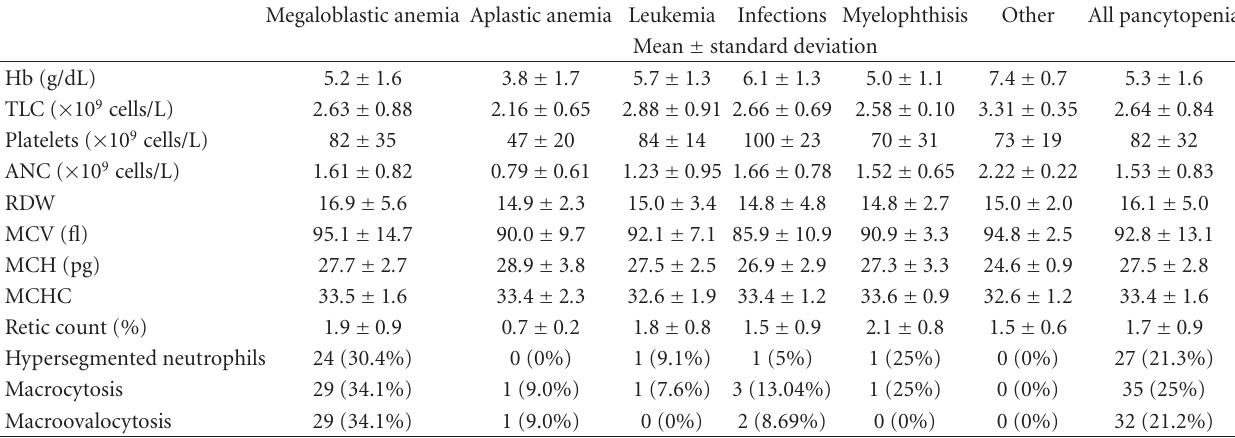
Table 2: Hematological parameters in